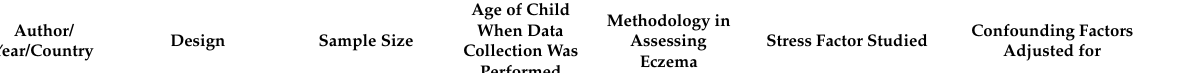
Exposure to stressful life events by mothers during pregnancy will increase the odds of the child having eczema Adjusted OR: 1.53, 95% CI: